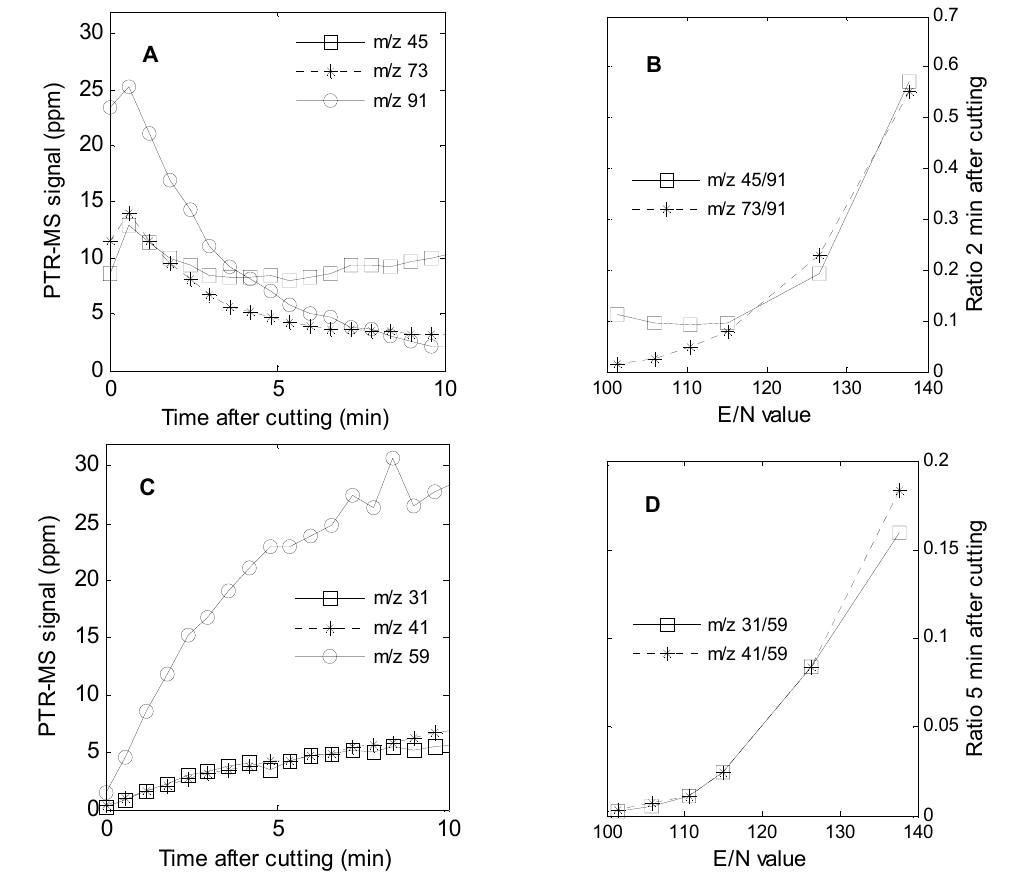
Figure 5. ( A ) Masses associated with the LF emitted 0–10 min after cutting at E/N value 137 Td. ( B ) Ratios m/z 45/91 and 73/91 2 min after cutting in experiments at different E/N values. ( C ) Masses associated with propanal emitted 0–10 min after cutting at E/N value 137 Td. ( D ) Ratios m/z 31/59 and 41/59 5 min after cutting in experiments at different E/N